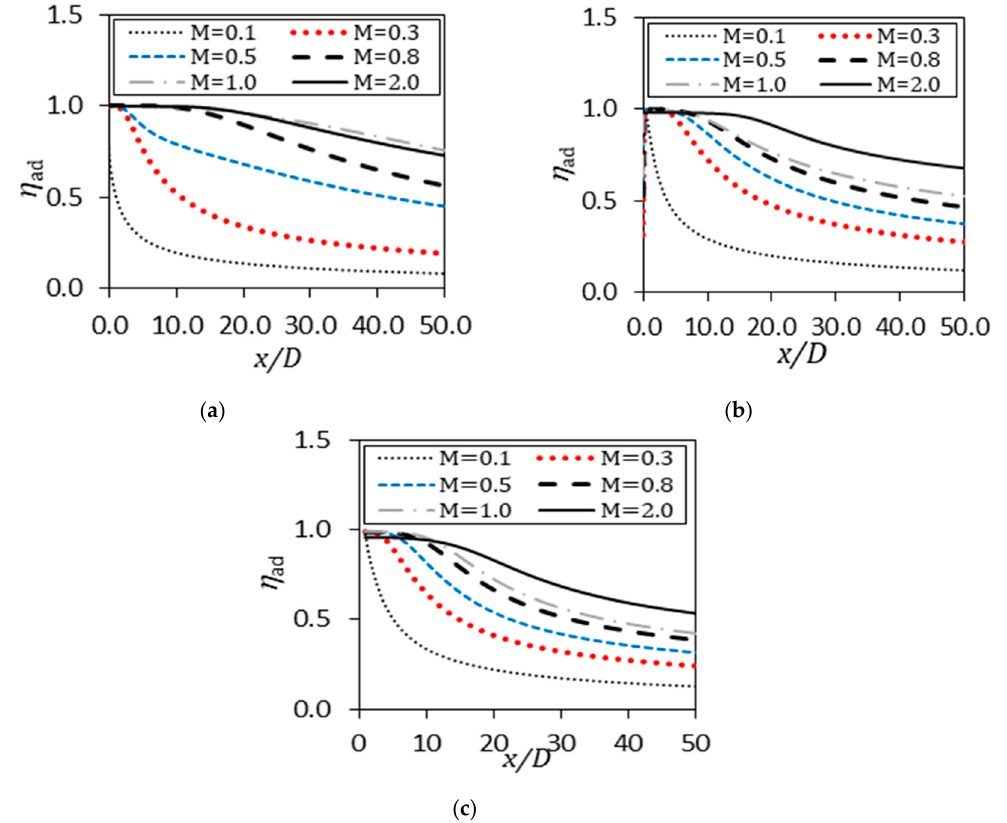
Figure 6. Adiabatic film cooling effectiveness (AFCE) variation with x direction for 𝐷𝑅 = 1.2 and injection angle of ( a ) 𝛼 = 30° , ( b ) 𝛼 = 60° and ( c ) 𝛼 = 90° . Table 2. Total of 54 numerical runs for different values of 𝑀 , 𝐷𝑅 and 𝛼 . Run No.